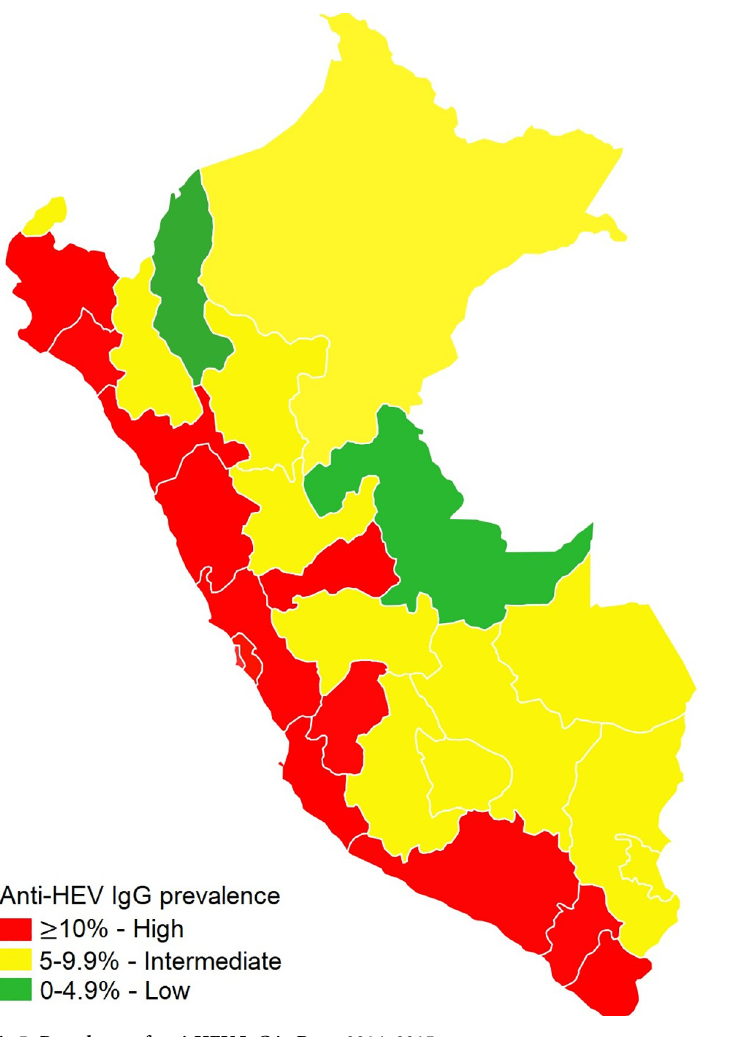
Fig 5. Prevalence of anti-HEV IgG in Peru, 2014–2015.